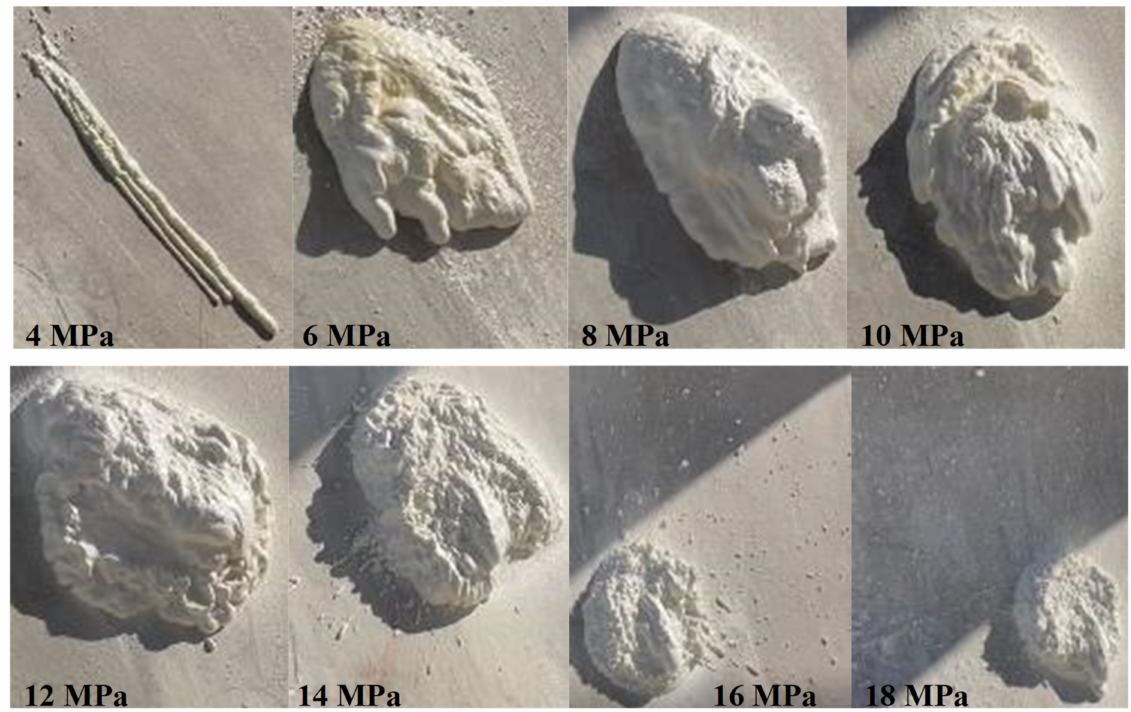
Figure 8. Spraying performance and diffusion radius at different σ spray